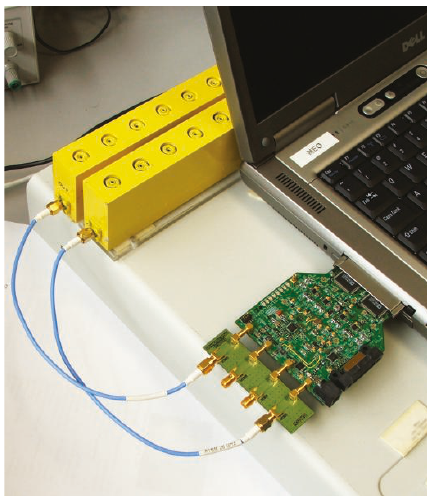
Table 2: Hardware characteristics of the Express MIMO